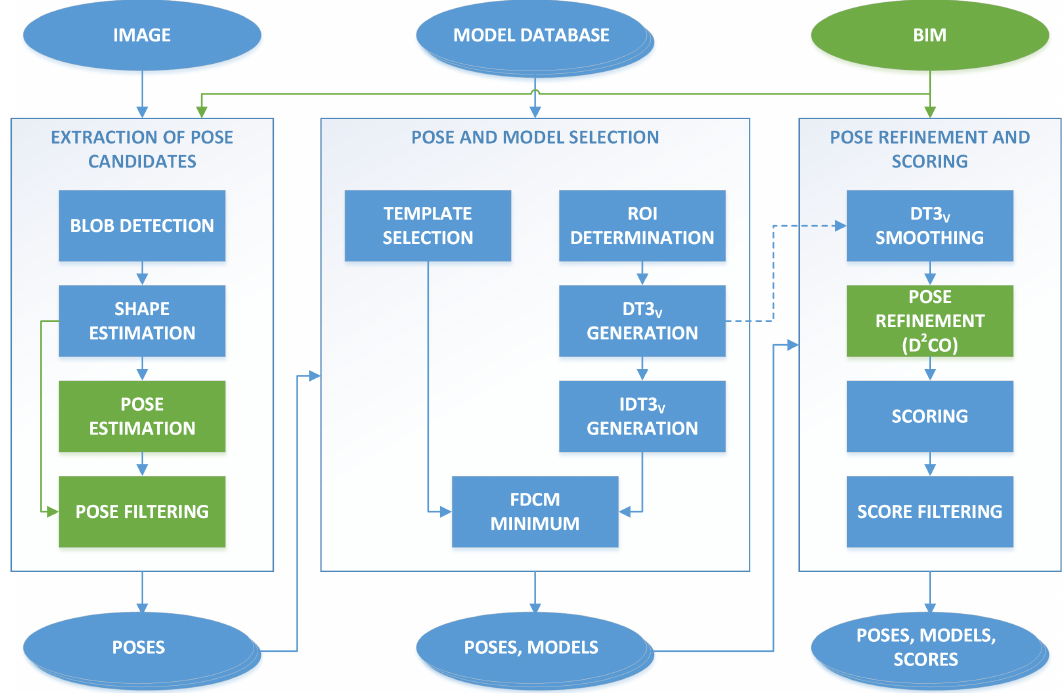
Figure 1. Diagram of the modified detection system, with the inclusion of building information modelling (BIM) data in the first and third steps. The modified parts with respect to [30] are highlighted in